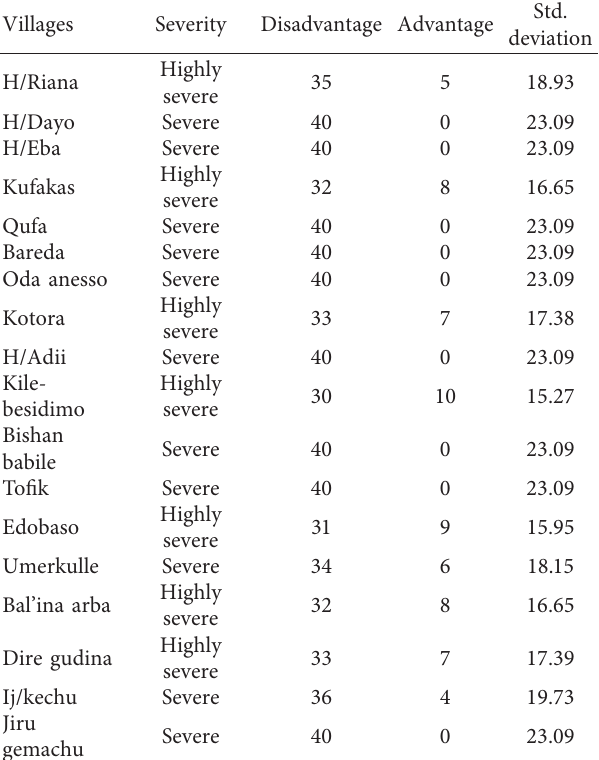
Table 2: Farmers’ responses on Striga severity, disadvantage, and advantage in percentage.